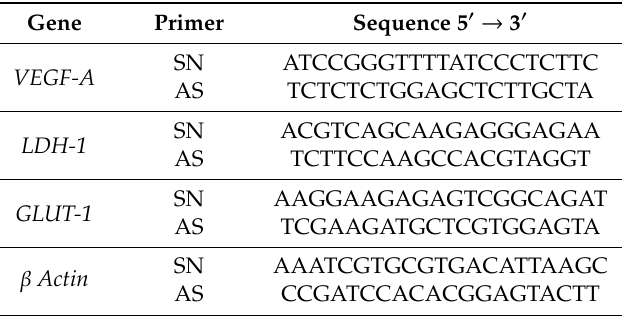
Table 1. Primers used for RT-PCR and qPCR analysis.